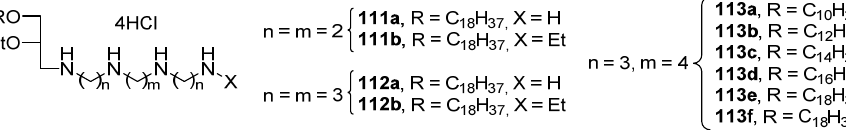
Figure 4. Antineoplastic lipophilic PAs. Lipophilic PAs were tested for antitumor activity against tumor cell lines of adenocar- cinoma of human chronic myelogenous leukemia (K562), colon (HCT116), and mammary glands (MCF7) using an MTT assay. All compounds affected tumor cell death at micro- molar concentrations, and they were four to five times more potent than the